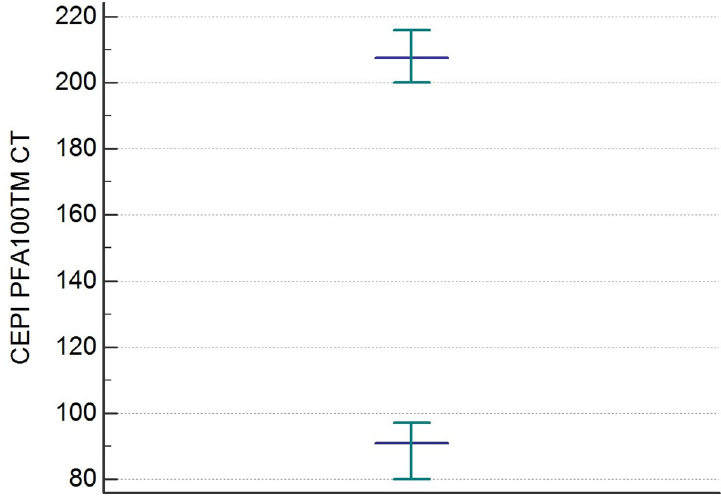
Fig 1. Reference intervals of CEPI PFA-100 CT determined by non-parametric percentile method (CLSI C28-A3).